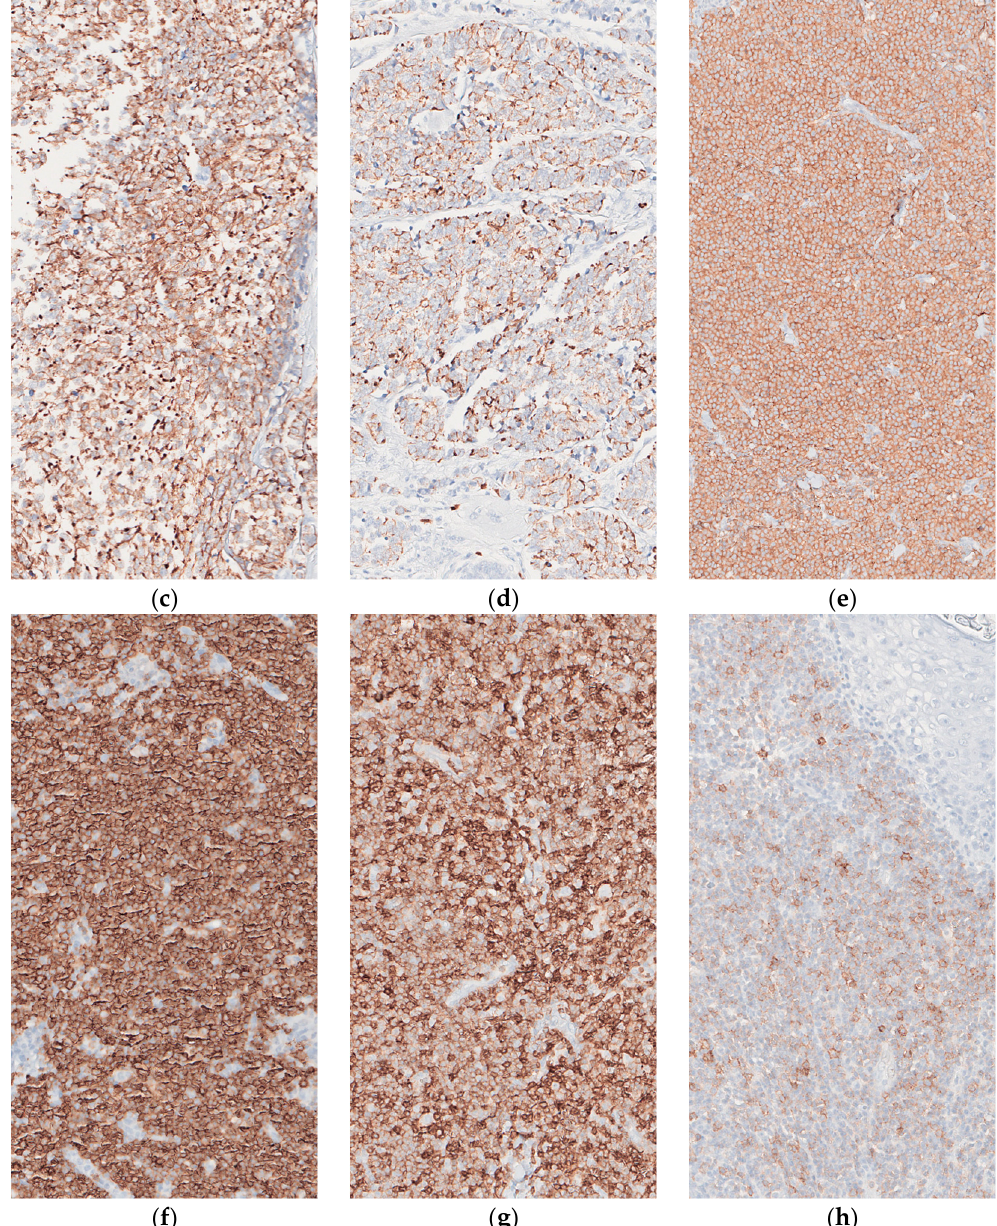
Figure 3. Case 3. ( a ) Right temple mass showing a high-grade neuroendocrine carcinoma with diffuse architecture and focally spindled morphology. ( b ) Sections from the 3 o’clock margin of the right-temple skin excision showing dermal infiltration by an atypical lymphoid proliferation consistent with a low-grade lymphoma further confirmed as CLL/SLL on subsequent immunohistochemistry (H&E; original magnification: ( a ) 20×; ( b ) 10×). Immunohistochemical stains of right temple mass ( c – e ) and adjacent right temple skin ( f – h ). ( c ) AE1/AE3 showing cytoplasmic and dot-like positivity in tumor cells (Magnification 20×). ( d ) CK20 showing a dot-like staining pattern in tumor cells (Magnification 20×). ( e ) Synaptophysin showing tumor cells with diffuse membranous and cytoplasmic staining (Magnification 20×). ( f ) CD20 diffusely highlights atypical B lymphocytes (Magnification 20×). ( g ) CD5 showing aberrant staining of neoplastic B lymphocytes (Magnification 20×). ( h ) CD23 showing faint membranous positivity in neoplastic B lymphocytes (Magnification 20×).